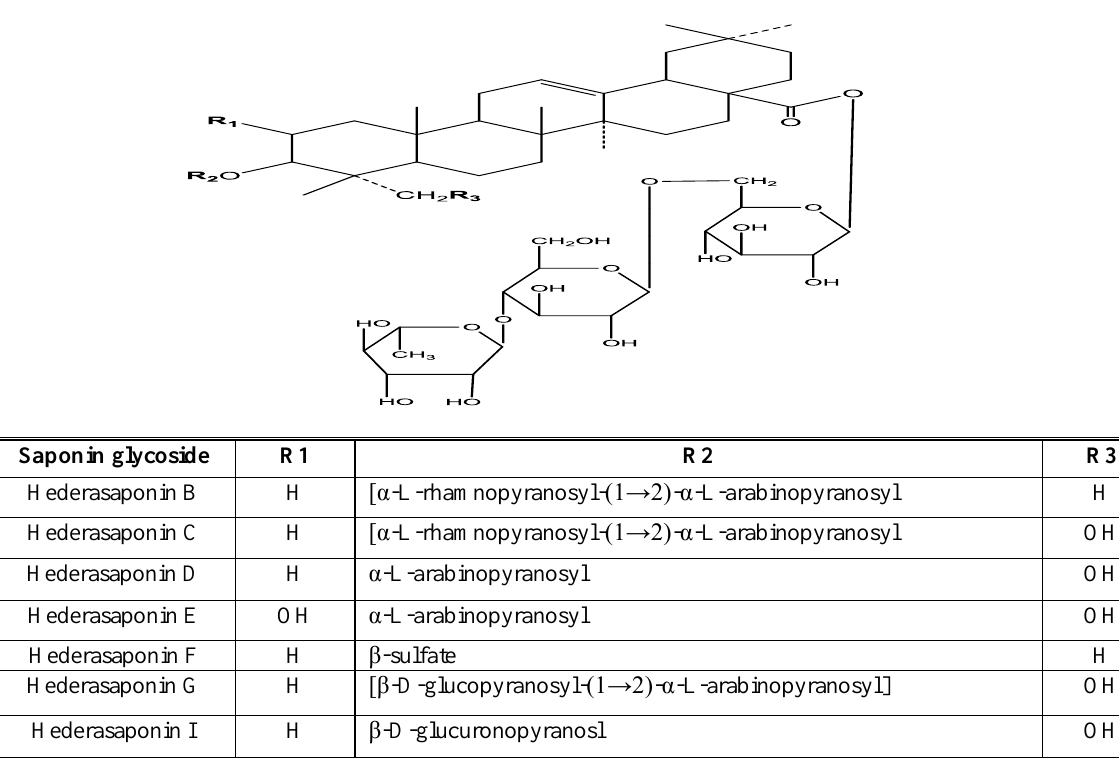
Table(1): Chemical structure of the major saponin glycosides of H. helix L. leaves (7,8)